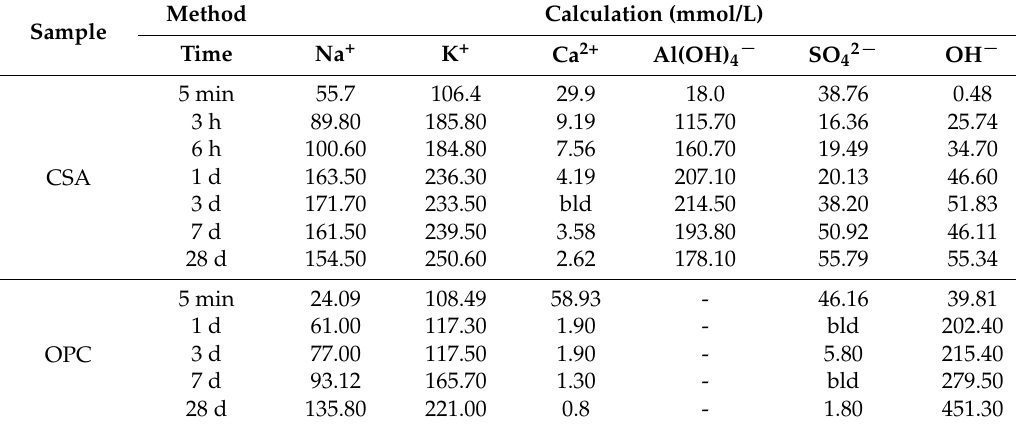
Table 5. Pore solution chemistry of OPC and CSA.